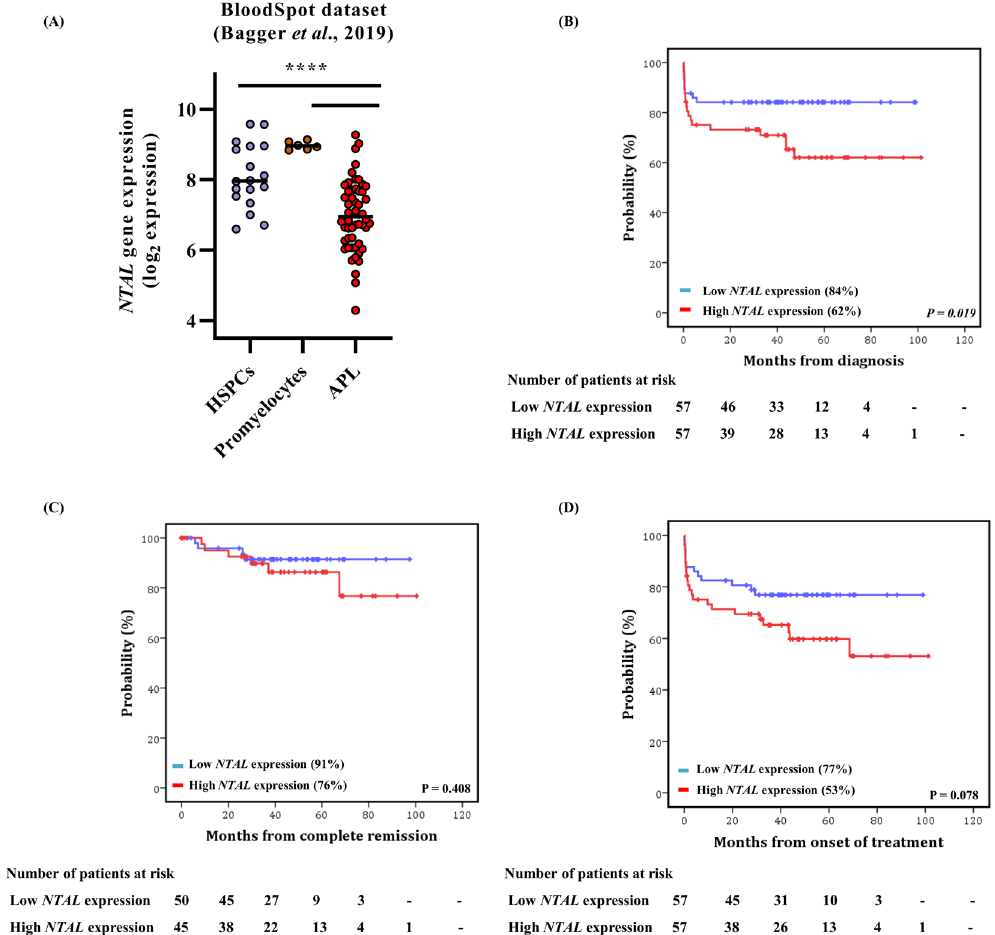
Figure 4. Differential gene expression of non-T cell activation linker (NTAL) in healthy bone marrow hematopoietic stem-progenitor cells (HSPCs), promyelocytes, and acute promyelocytic leukemia (APL). ( A ) NTAL transcript levels in samples from patients with APL and comparative controls identified in the BloodSpot databank, which was used as a validation cohort. NTAL transcript levels were compared between newly diagnosed APL patients and healthy donors cells, including HSPCs and purified promyelocytes. ( B ) The probability of overall survival (OS) ( C ), disease-free survival (DFS) ( F ), and event-free survival (EFS) ( D ), in patients with APL and relative to NTAL expression (International Consortium on Acute Leukemia – ICAL2006 cohort). The horizontal bars represent the median value of NTAL expression. NTAL expression was lower in APL samples as determined by the Kruskal-Wallis test followed by the Dunn post-hoc